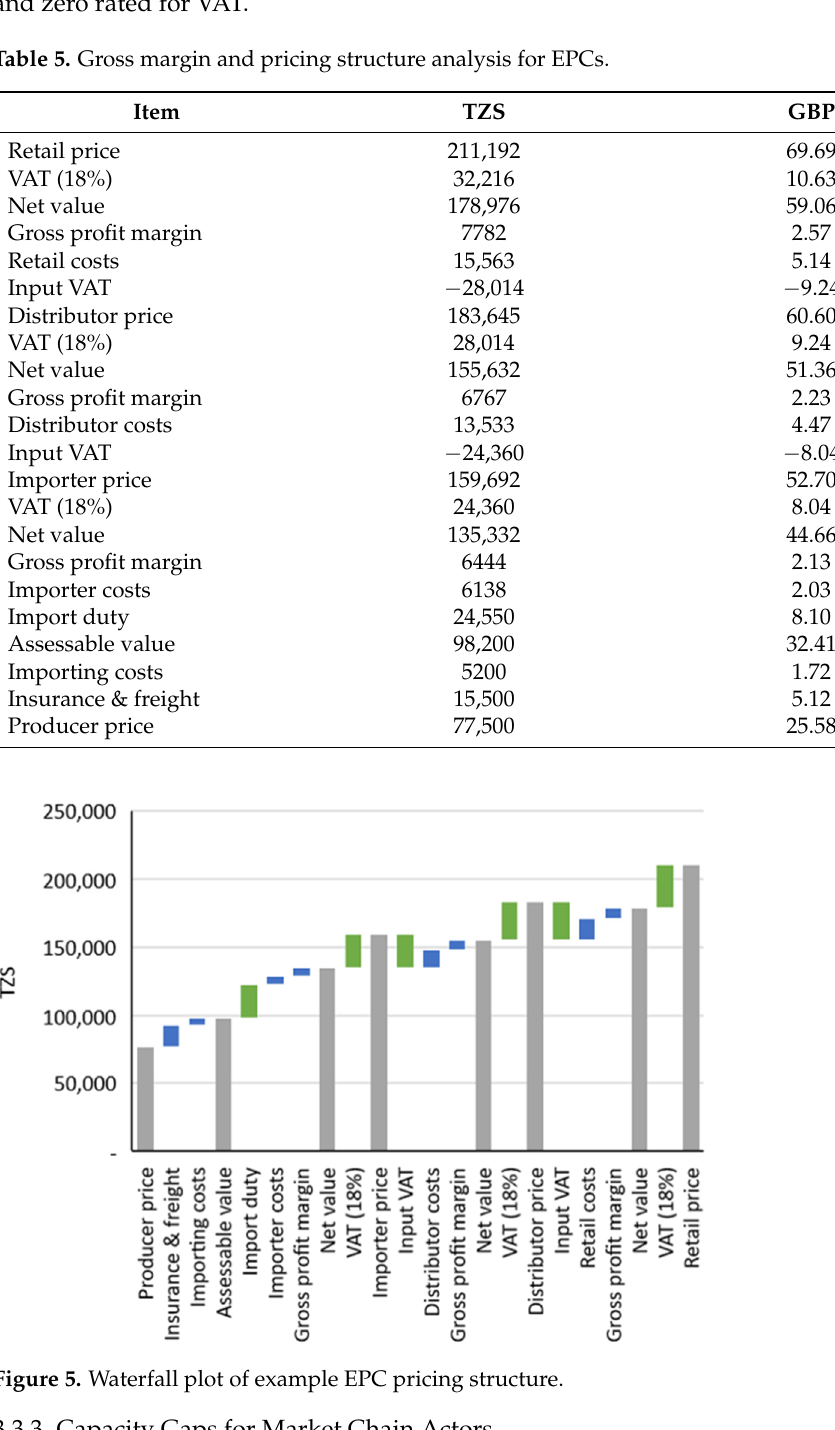
Table 5. Gross margin and pricing structure analysis for EPCs.